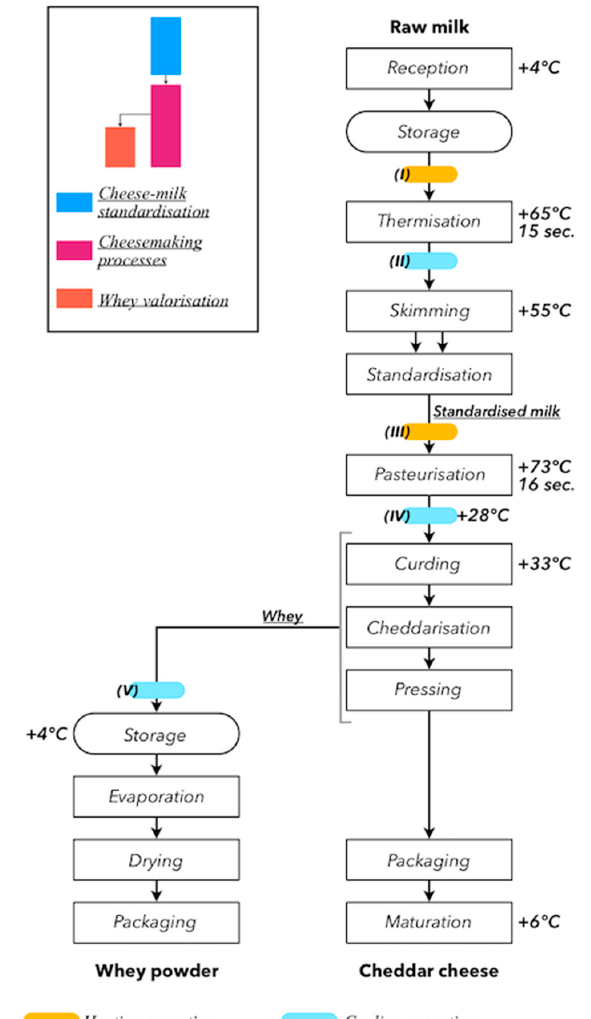
Figure 2. Process flow diagram of scenario C. Based on the information from Tetra Pak [18].